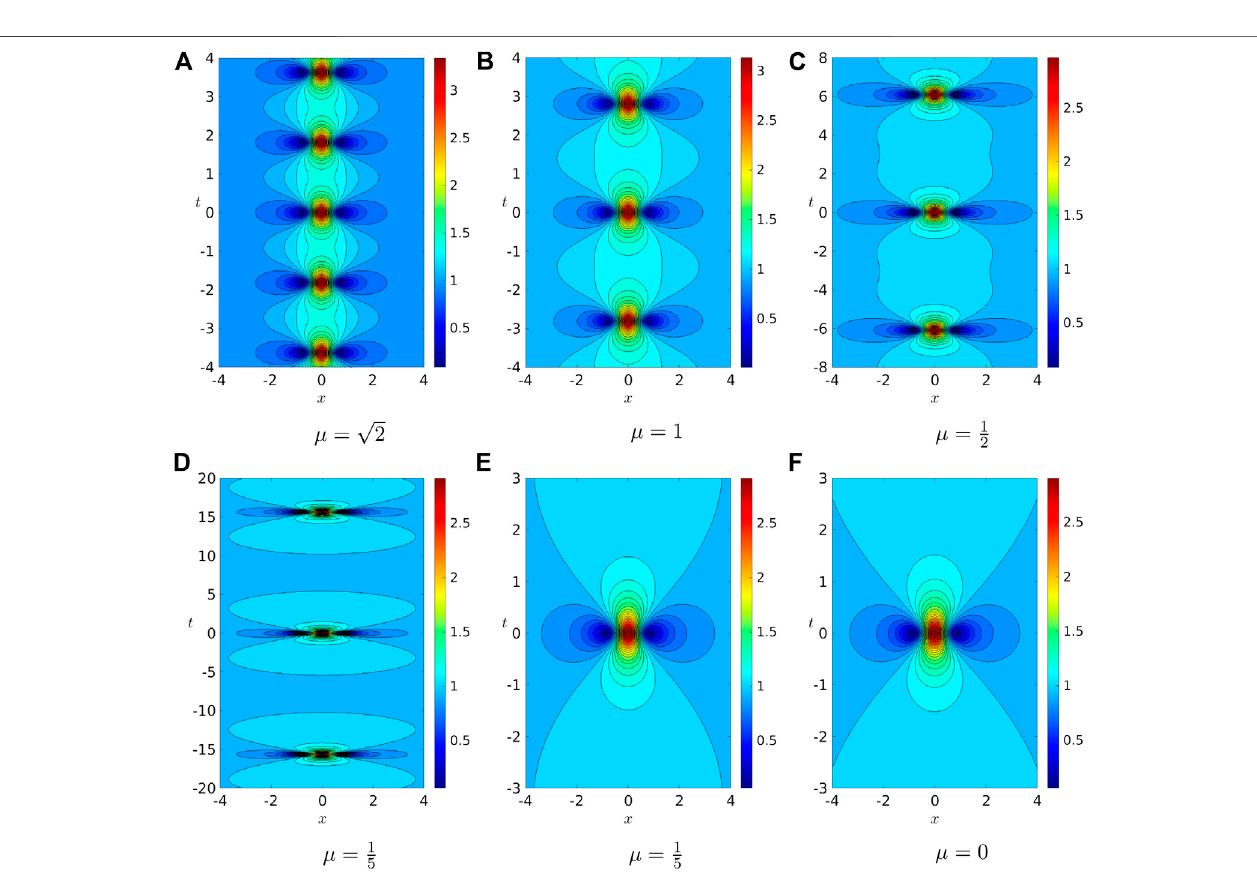
(cid:7)(cid:7) √ 2 , (B) μ (cid:2) 1, (C) μ (cid:2) 0 . 5, (D) μ (cid:2) 0 . 2, (E) also μ (cid:2) 0 . 2butazoom-inversion,and